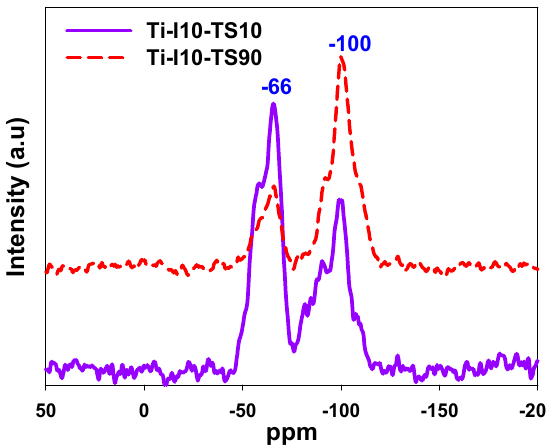
Figure 8. The 1 H- 29 Si-CP MAS NMR spectra for the Ti-I10-TS10 and Ti-I10-TS90 samples.